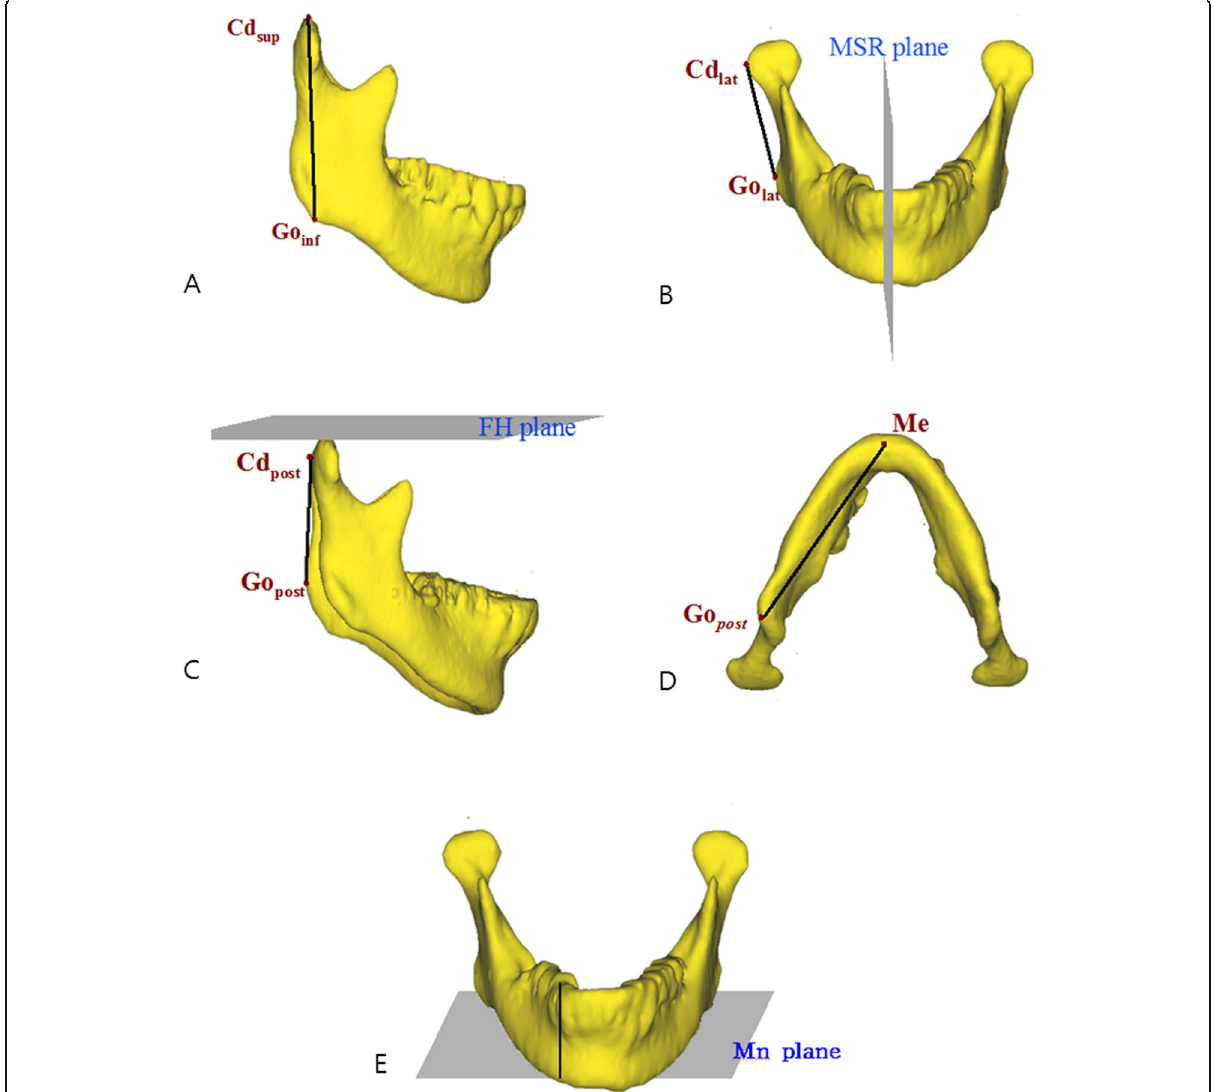
Fig. 3 The measurements of the mandible. a Ramus length. b Frontal ramal inclination. c Lateral ramal inclination. d Body length. e Body height (reproduced with permission [14])